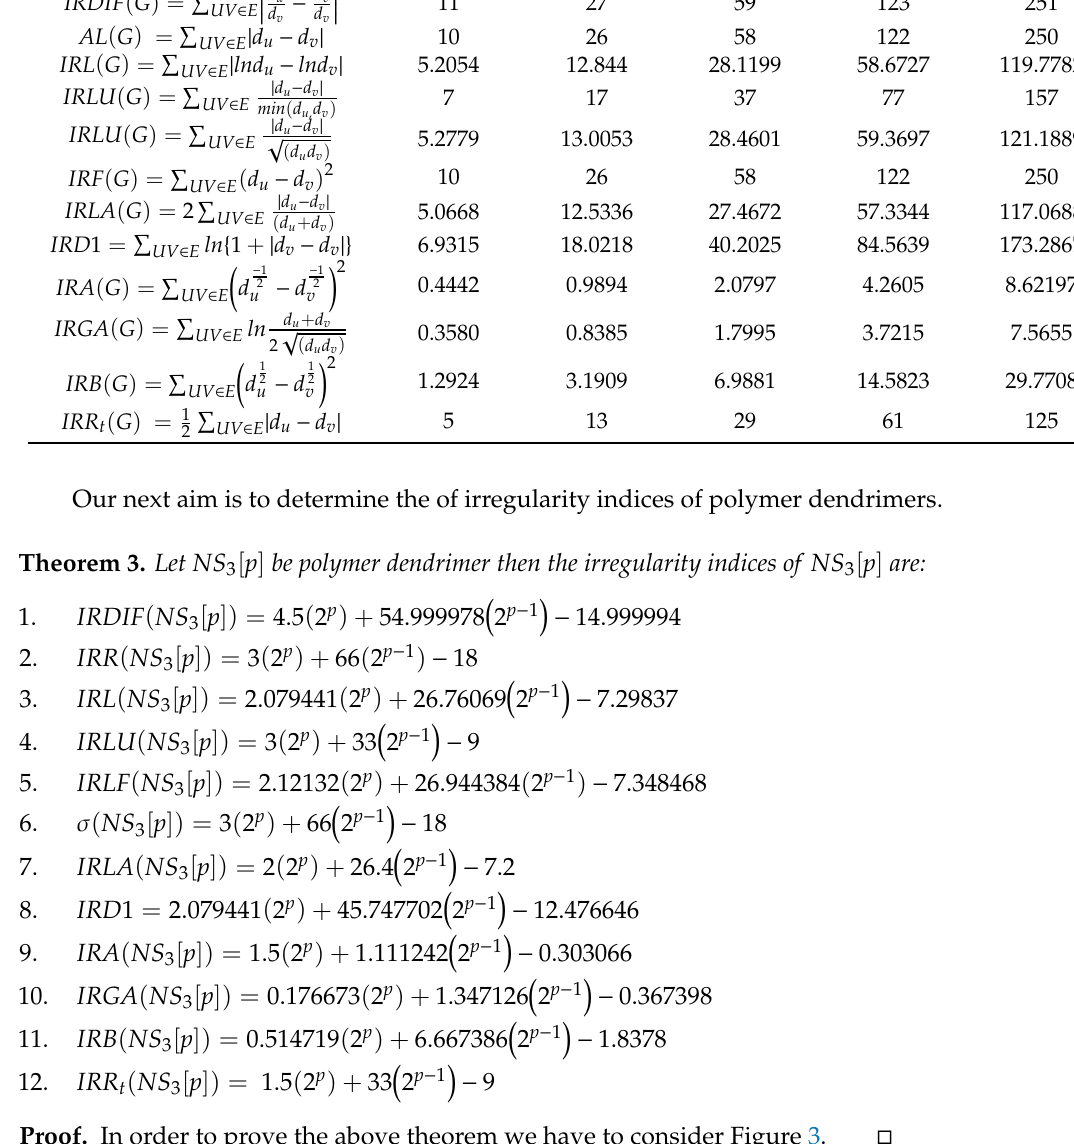
Table 4. Irregularity indices for NS 2 [ p ] polypropylenimine octaamin dendrimers. Irregularity indices p = 1 p = 2 p = 3 p = 4 p = 5 (cid:12) (cid:12) (cid:80) (cid:12) (cid:12) d u − d v (cid:12) (cid:12) IRDIF ( G ) = (cid:12) (cid:12) UV ∈ E d v d v